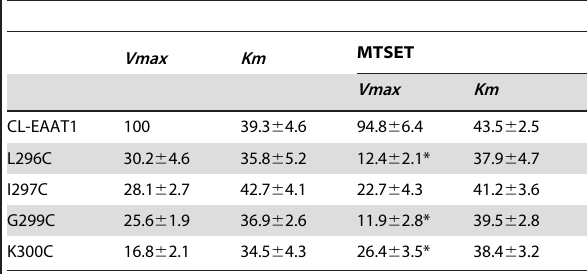
Table 1. Kinetic parameters of CL-EAAT1 and single cysteine